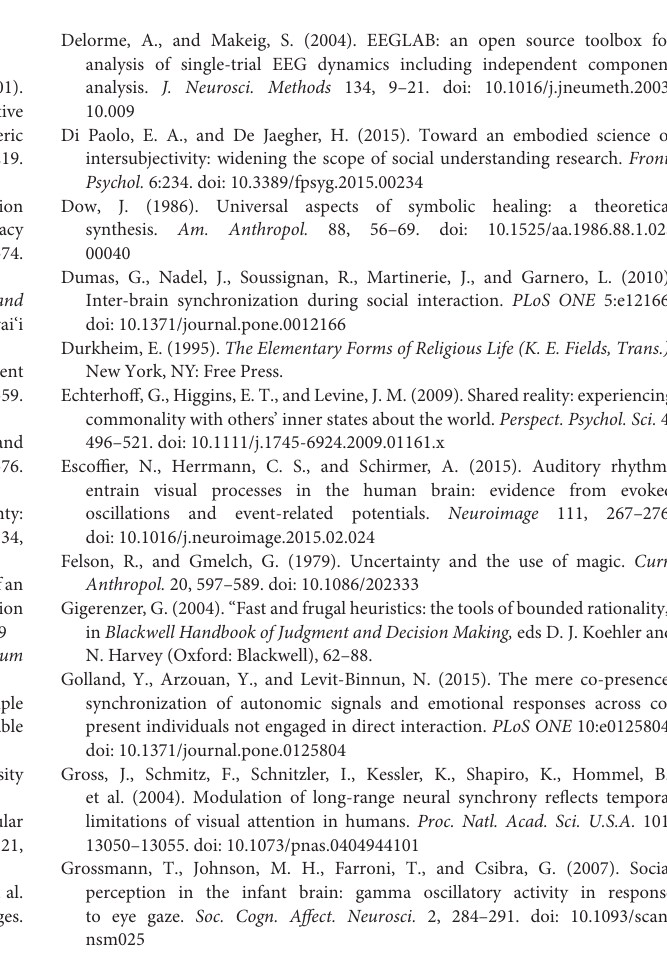
Supplementary Video 1 | Example of High Efficacy Ritual. Supplementary Video 2 | Example of Medium Efficacy Ritual. Supplementary Video 3 | Example of Low Efficacy